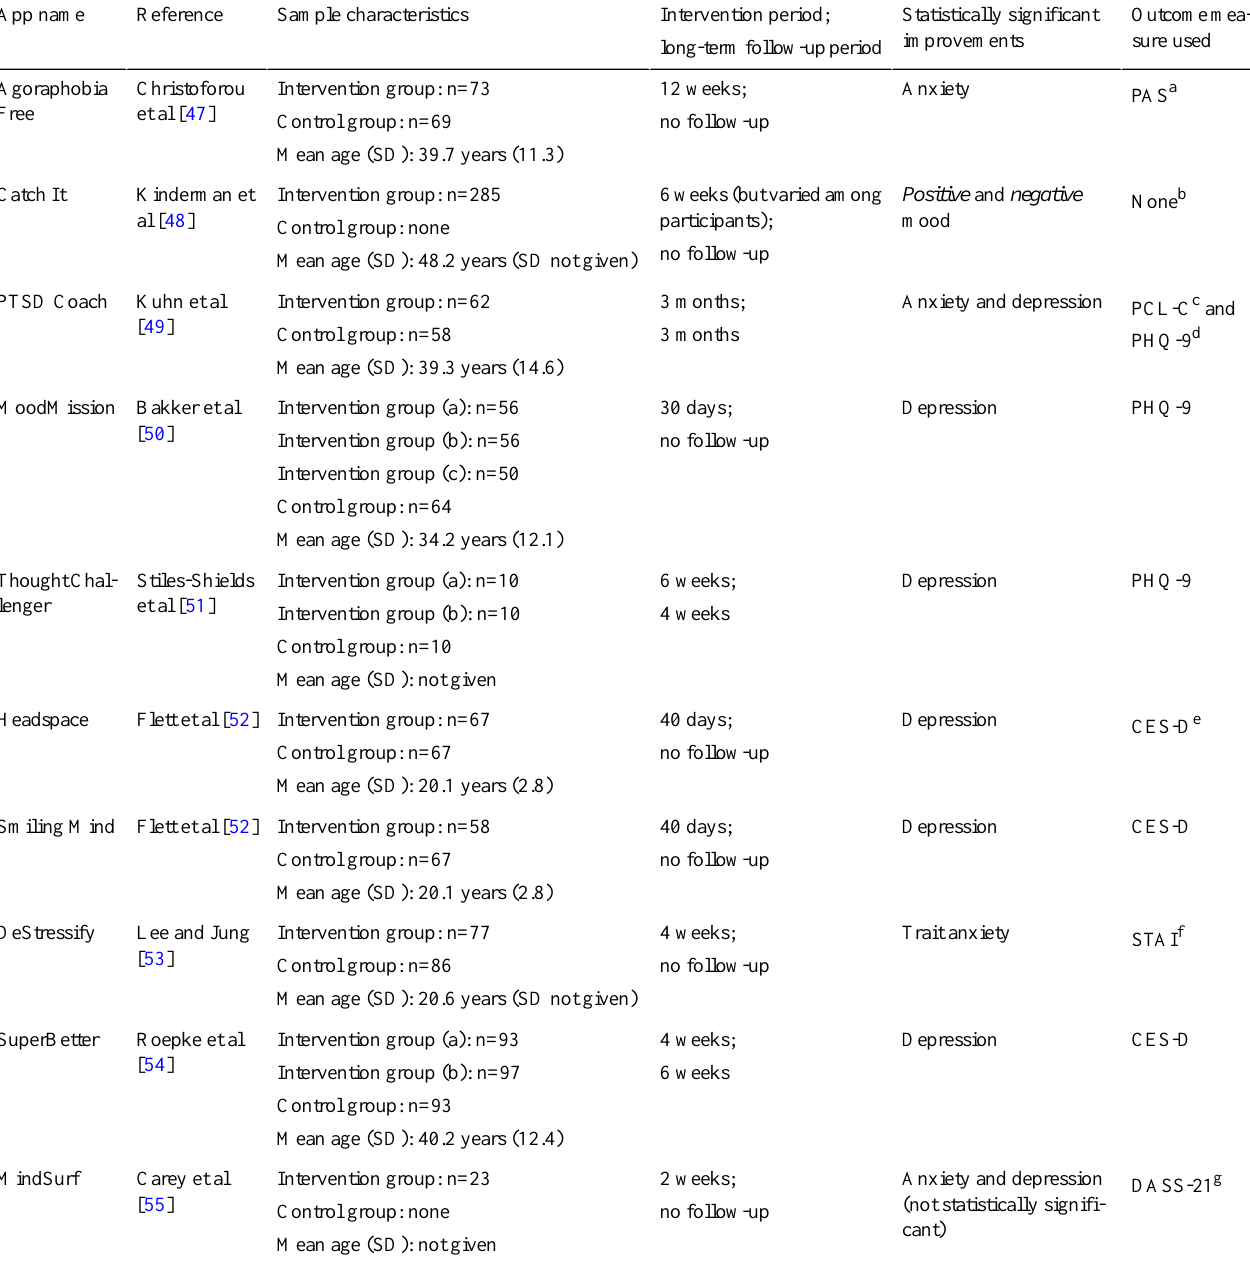
Table 2. Summary of published research for shortlisted apps.